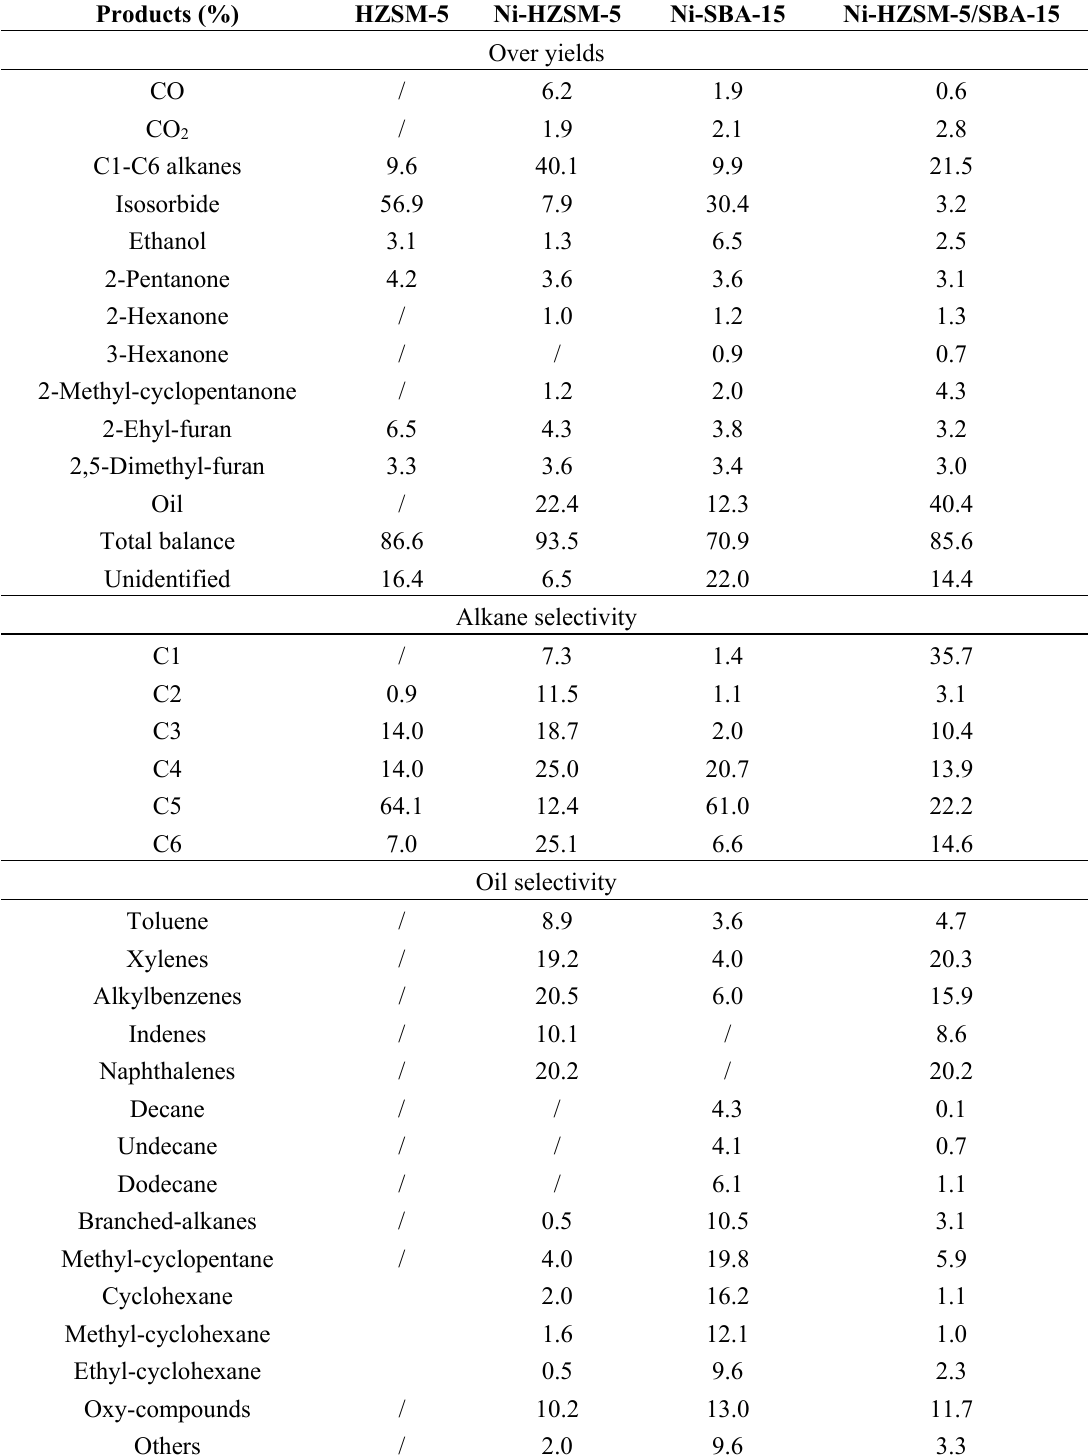
Table 3. Product distribution over different